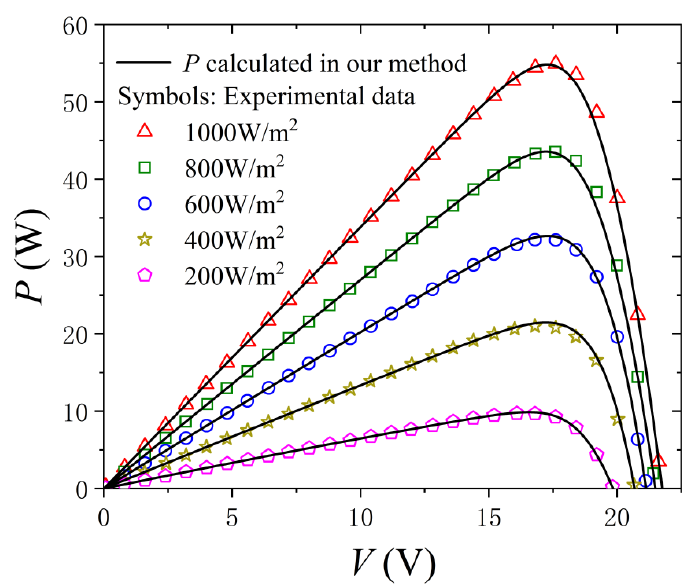
Figure 8. P-V characteristics measured and calculated, respectively, for the thin-film SM55 PV panel in different irradiance conditions.